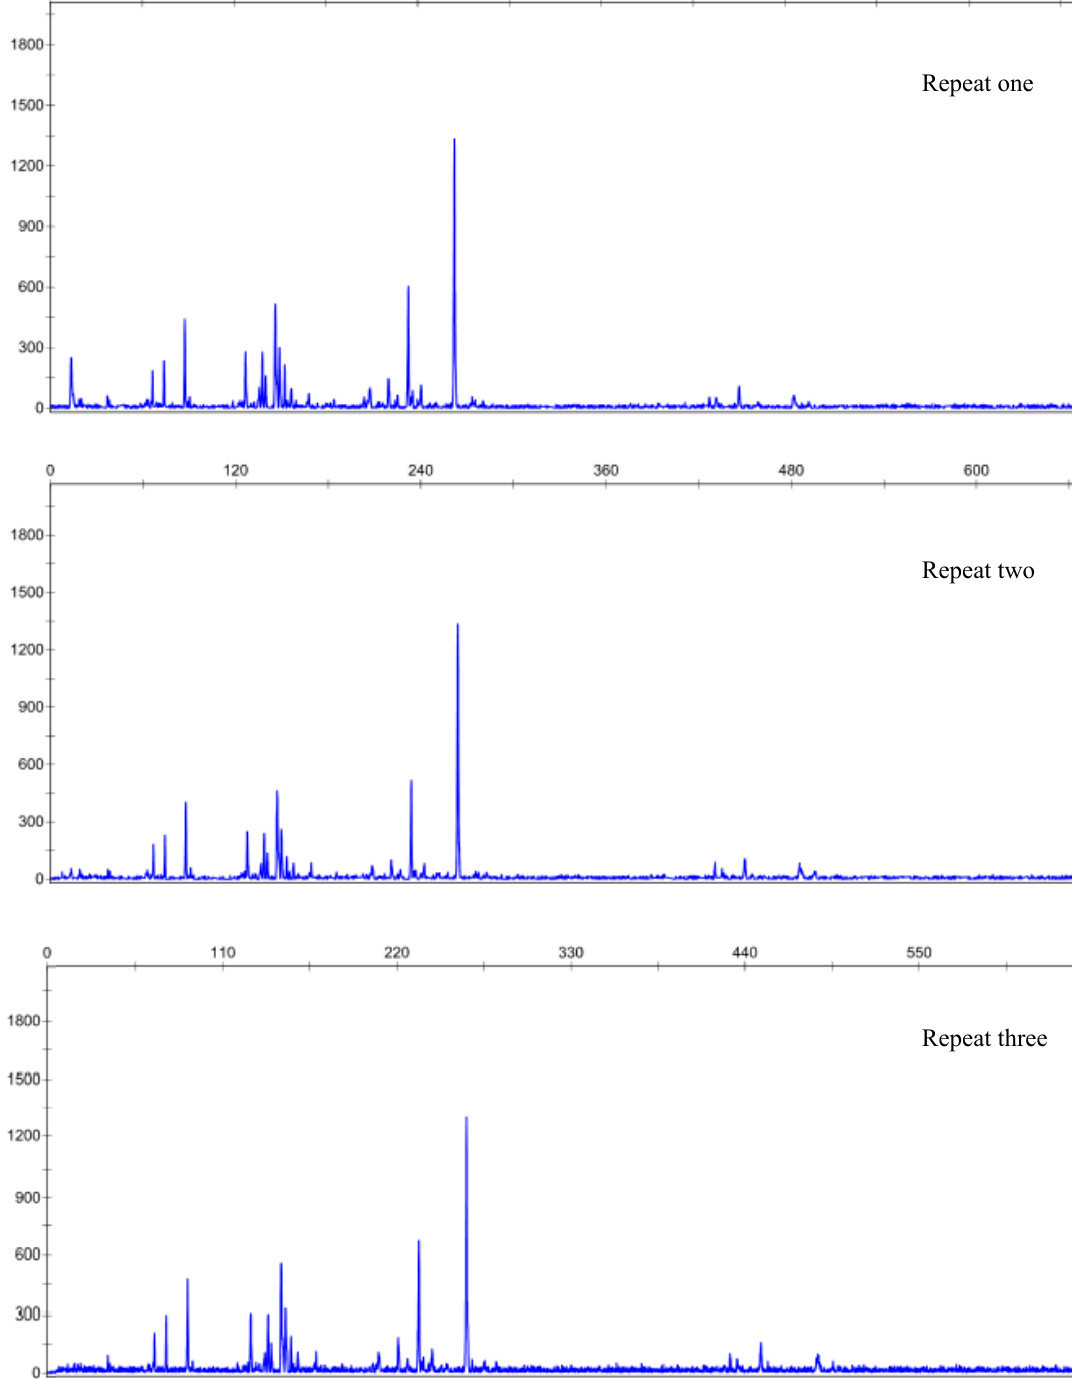
Fig. S3: T-RFLP chromatogram of fungi in rhizosphere soil of tea tree with pH value